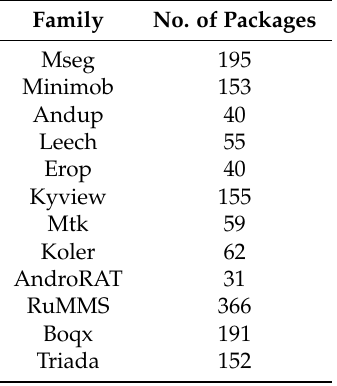
Table 2. Selected package per family for the AMD